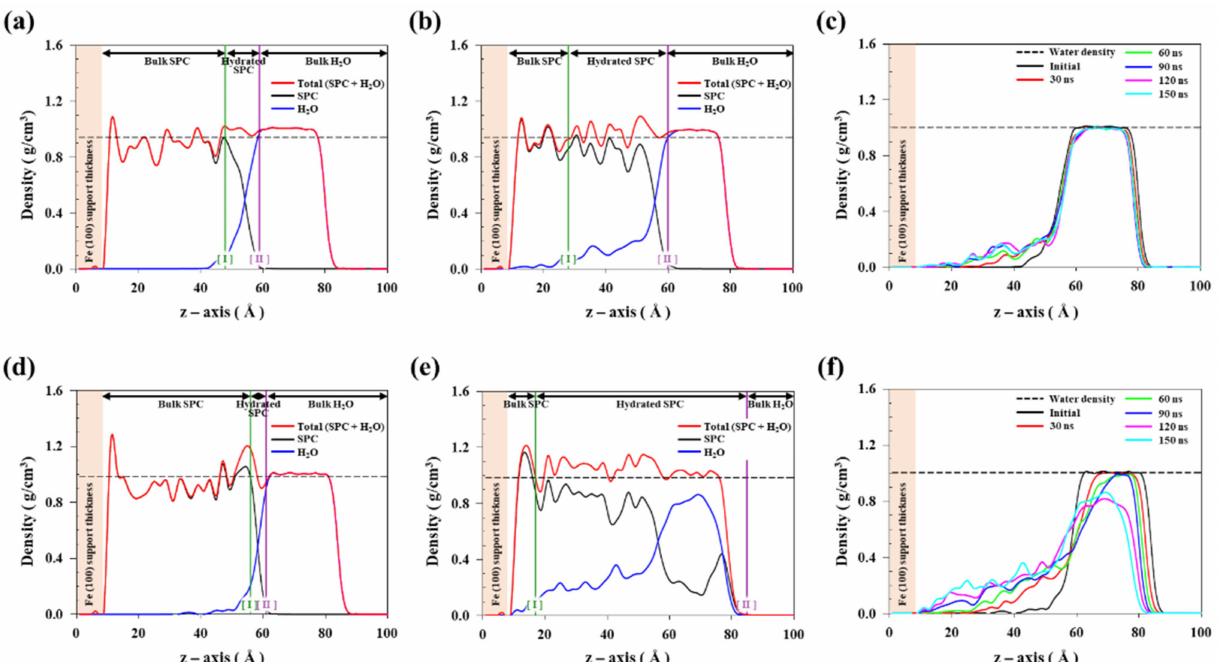
Figure 4. Density distributions of the sums of hydrated SPC + H 2 O molecules (red), SPC (black), and H 2 O molecules (blue): initial ( a ) Z2 and ( d ) Z16 states, and final ( b ) Z2 and ( e ) Z16 states. The black dash line shows the density of bulk SPC. The highlighted [I] and [II] lines delineate the bulk SPC and H 2 O regions, respectively, based on 90% of the bulk states of SPC and H 2 O molecules. Density distributions of H 2 O molecules in ( c ) Z2 and ( f ) Z16 over time (initial to 150 ns). The black dashed line shows the density of bulk H 2 O